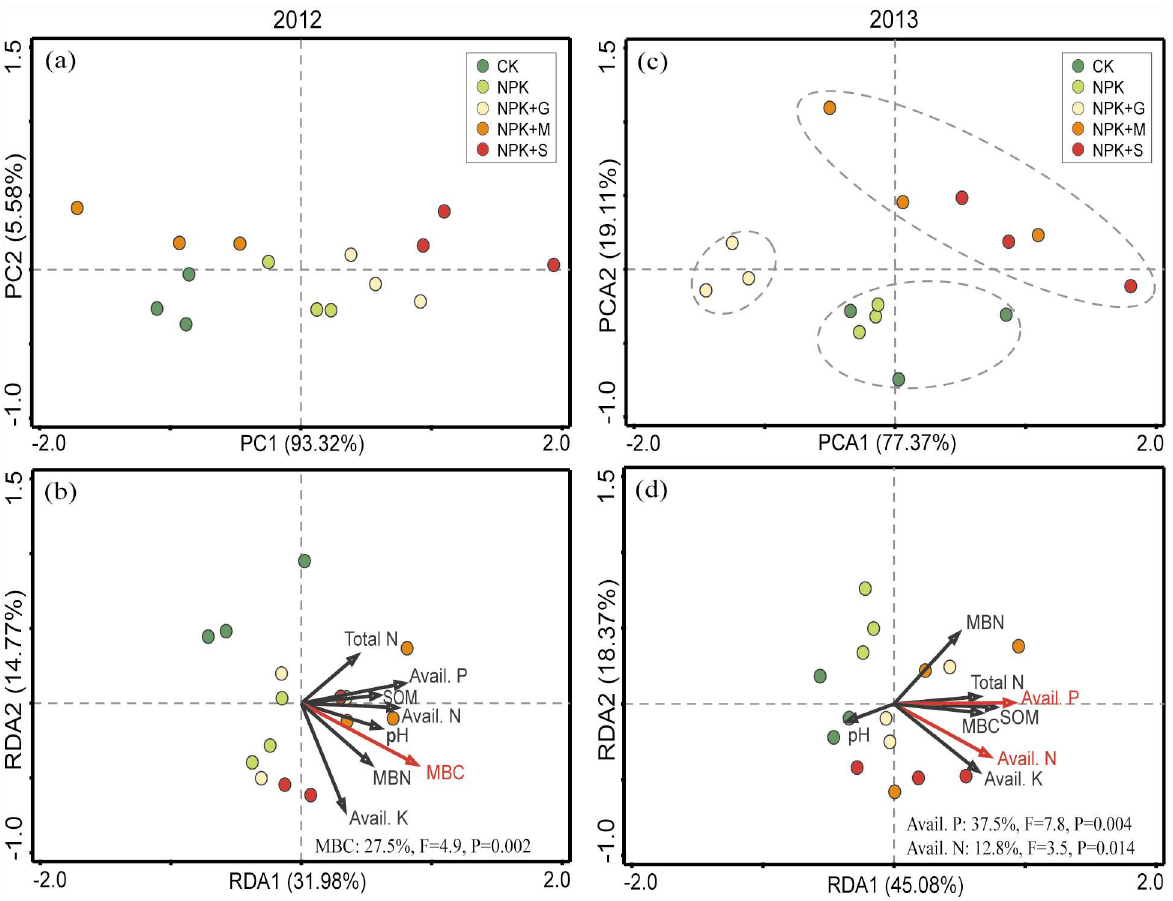
Fig 4. Principal Component Analysis (PCA) of enzyme activities in soils different fertilizations in the late rice season of 2012 (a) and the early rice season of 2013 (c), and Redundancy Analysis (RDA) results of the correlations between soil variables and enzyme activity in the late rice season of 2012 (b) and the early rice season of 2013 (d). The red arrows indicate the soil parametersthat had a strong and significantimpact on the enzyme activities ( P < 0.05), and the corresponding explainedproportionof variabilityis shown in the lower right corner. Abbreviations: Abbreviations: Avail ., available; MBC , microbialbiomass carbon; MBN , microbialbiomassnitrogen; SOM , soil organicmatter.